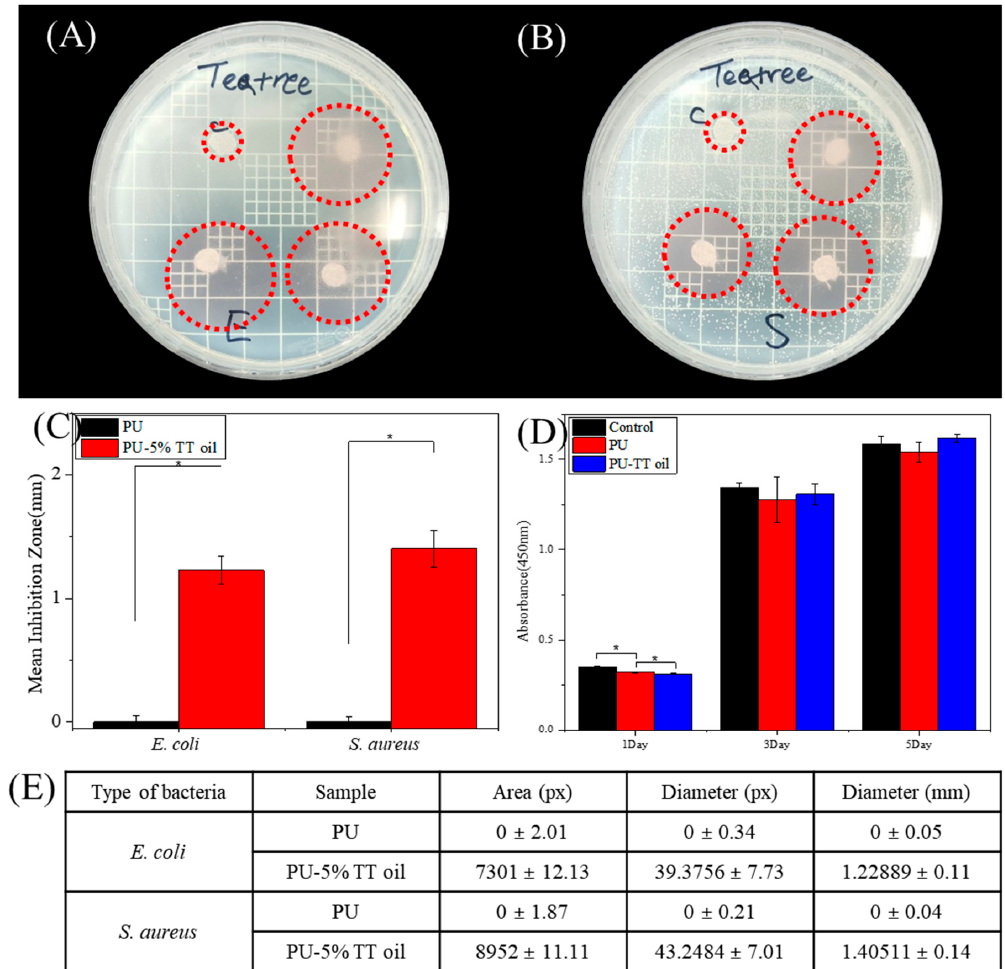
Figure 3. Representative images of the zone of inhibition using ( A ) Escherichia coli and ( B ) Staphylococcus aureus after 24 h after adhered samples. ( C ) The graph of inhibition zone diameter by Image J software. The data represent the mean three standard deviations with statistical significance. ( D ) Cytotoxicity test by CCK-8 assay on NIH-3T3 cell culture onto each sample at day 1, 3 and 5. ( E ) Comparison of antibacterial e ff ect of PU and PU-5% TT oil using di ff erent type of bacteria (* indicates statistical significance ( p < 0.05) measured by a one way ANOVA Tukey